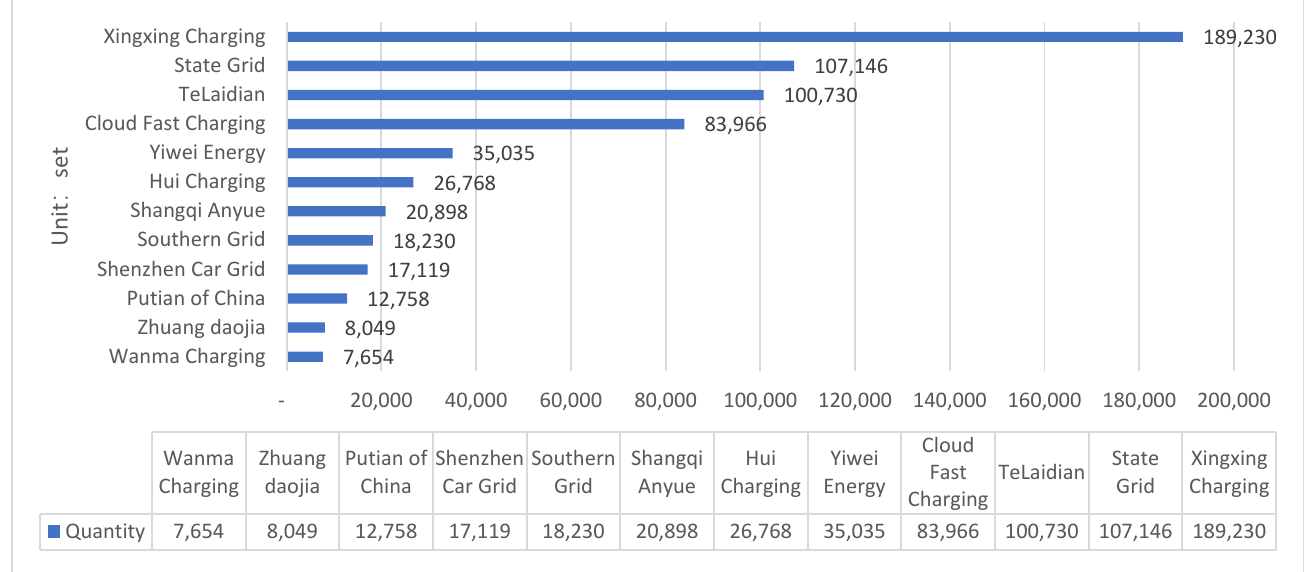
Figure 4. Ranking the market share of charging pile operators in China in 2021. Data source: Public policy documents of the government